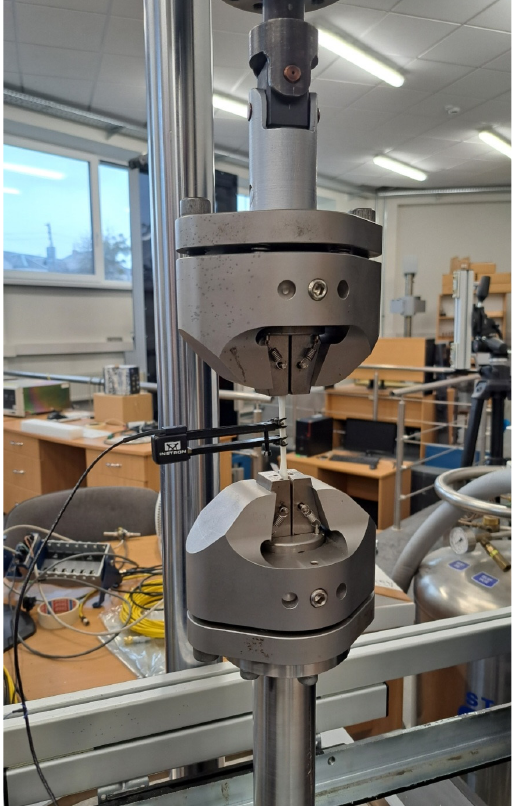
Figure 3. Mechanical testing machine: ElectroPuls ® E10000 Linear-Torsion.